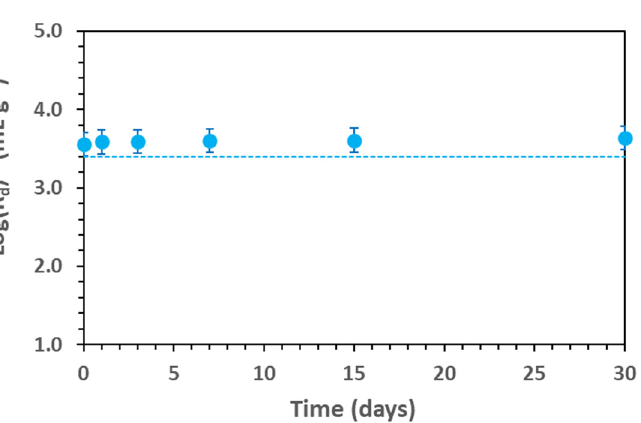
Figure 2. Cd adsorption kinetics in Na-smectite (0.6 g · L − 1 ). [Cd] = 9.2 × 10 − 8 M; pH = 7 in 0.1 M NaClO 4 . The line represents the model calculation with the parameters of Table S1.